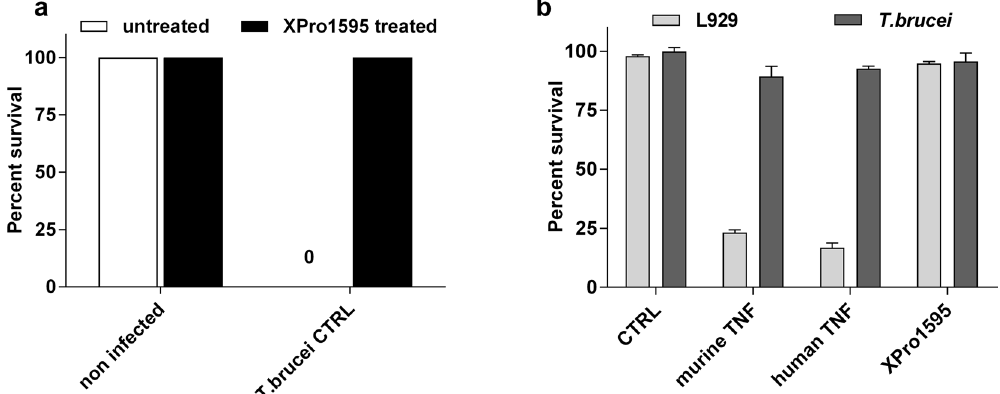
Figure 1. XPro1595 treatment abolishes infected mice hypersensitivity to LPS challenge and does not lyse T. brucei in vitro . ( a ) Survival of C57Bl/6 mice infected or not with T. brucei control (CTRL) parasites and treated (black) or not (white) with 10 mg/kg of XPro1595. At day 14 of infection, mice were injected ip with 5 µ g of LPS and their survival was recorded after 48 h (mean ± SEM, n = 3). (b) In vitro TNF lysis assay. L929 cells and T. brucei parasites were exposed to 50 ng/ml of murine or human TNF, as well as XPro1595 (mean ± SEM, n = 3 for L929 and n = 6 for T. brucei ). A significant (p-value = 0.0001, Dunnett’s corrected 2-way ANOVA) effect of TNF was observed on the L929 cell line, but no significant trypanolysis was